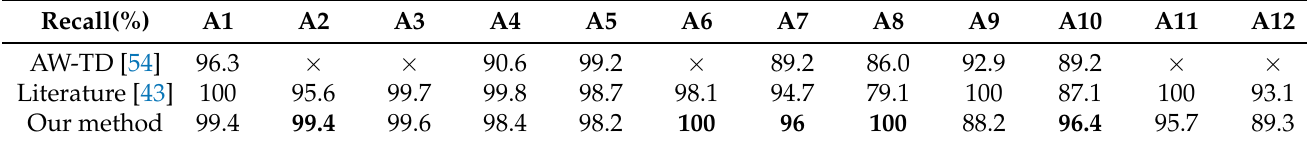
Table 6. Comparison of recall rate between the proposed method and other